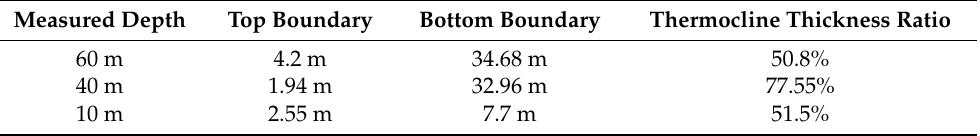
Table 2. Thermocline